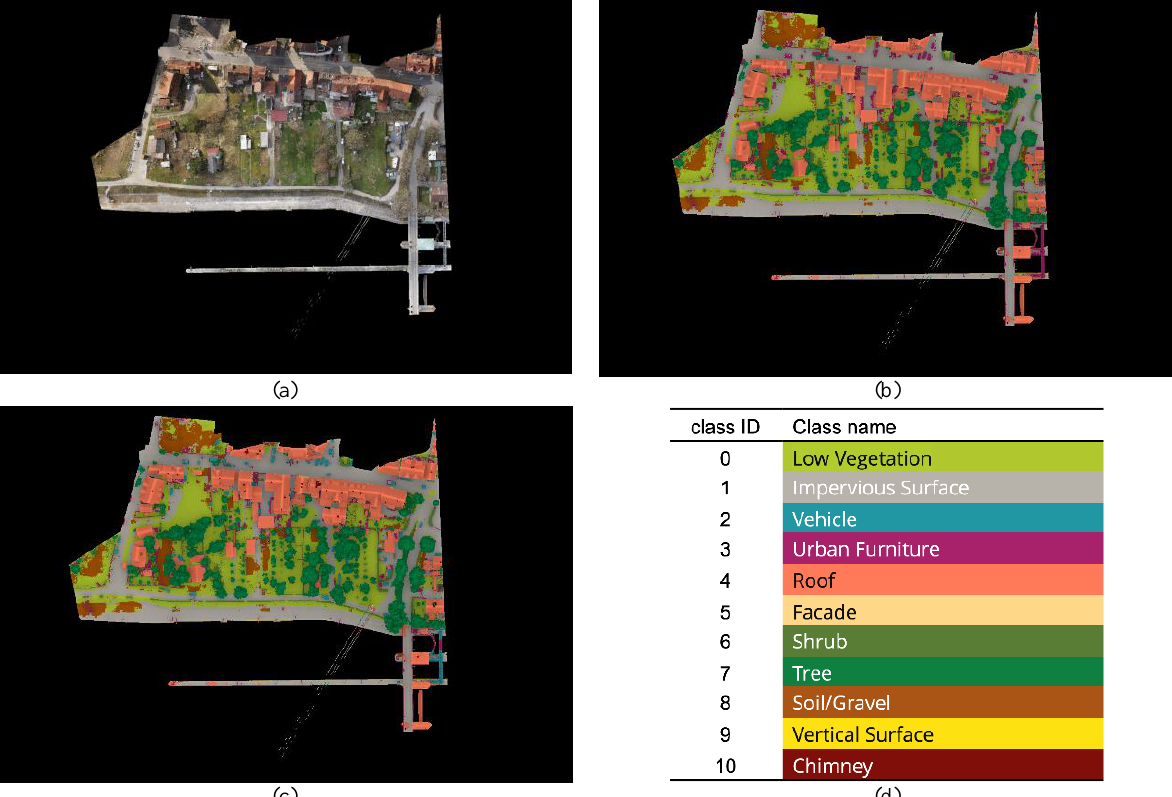
Figure 4. Visualization of the test results on (a) point cloud with RGB (b) the single-stage segmentation (c) our proposed two- stage approach (d) the class catalog of the H3D